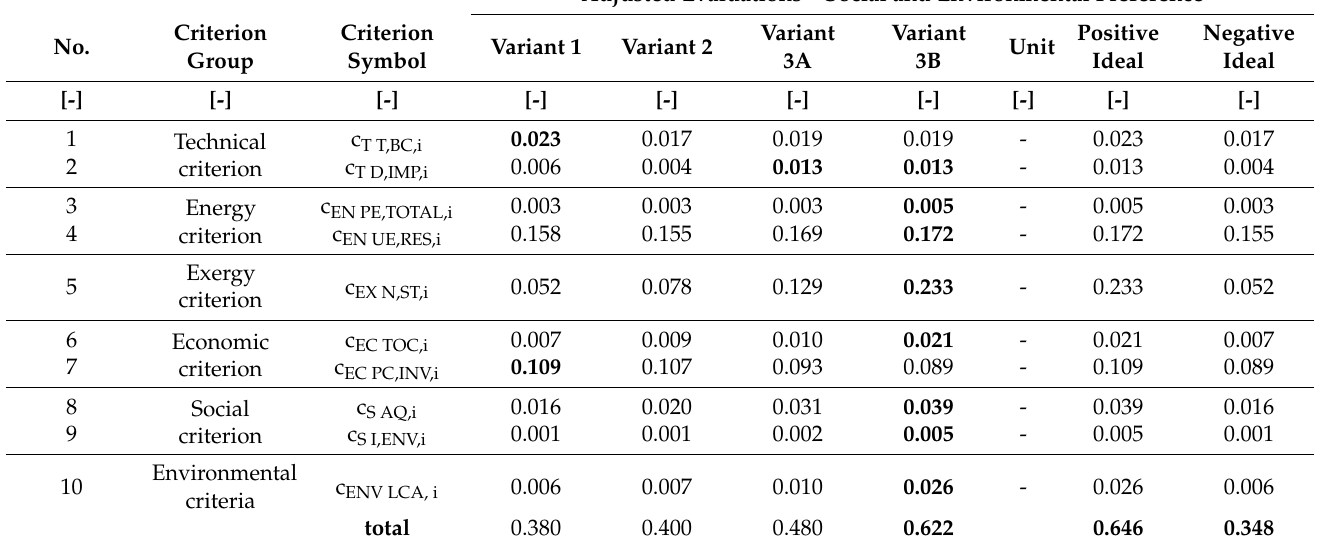
Table 10. Adjusted scores in the evaluation criteria for individual variants: The ‘social and environ- mental preference’ group.